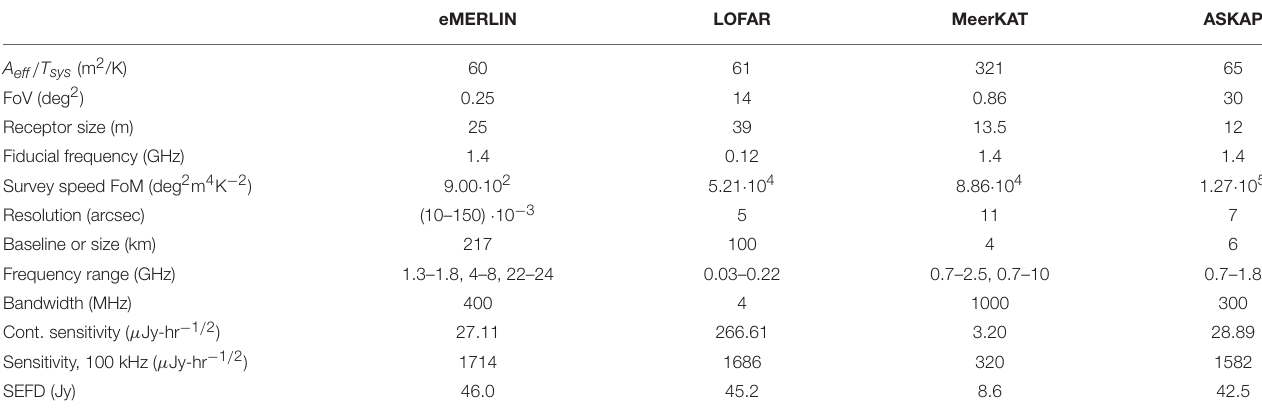
TABLE 3 | Parameters for the SKA precursors and pathfinders described in the text, according to Dewdney et al. (2013); see https://www.skatelescope.org/wp-content/ uploads/2012/07/SKA-TEL-SKO-DD-001-1_BaselineDesign1.pdf. eMERLIN